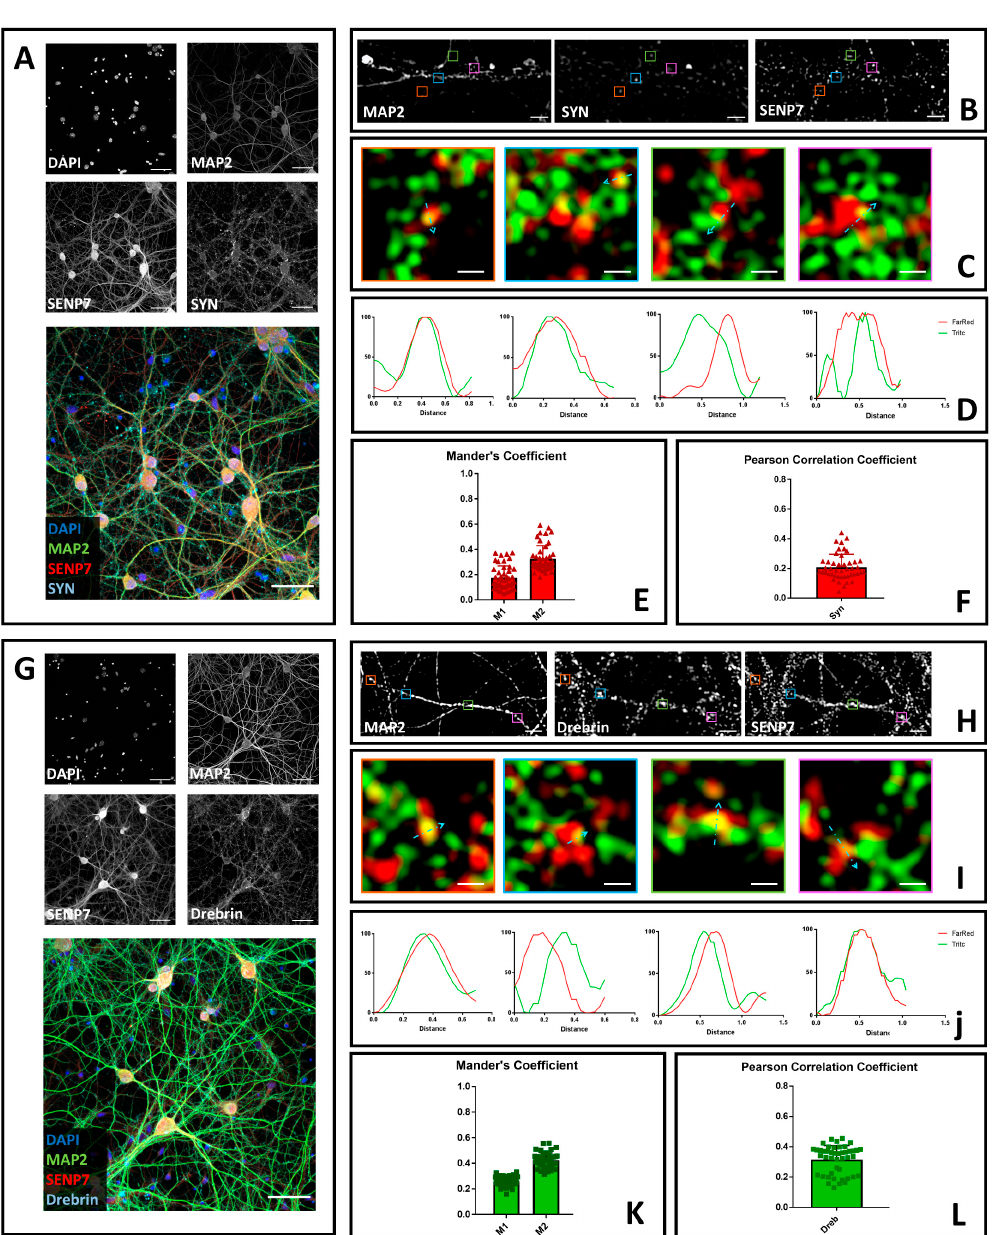
Figure 3. Confocal and SIM microscopy to determine the neuronal localization of SENP7. ( A ) Neurons were fixed and stained with anti-SENP7 (red), anti-synaptophysin (light blue) and anti-Map2 (green). Images were obtained using a Nikon N-SIM confocal microscope and overlaid to assess protein localization. Nuclei were stained with Hoechst. Scale bar of 50 μ m. ( B ) 3D-SIM images acquired with a 100× objective. Scale bar of 2 μ m. Squares represent the location of the inset present in panel C. ( C ) Merge images of reconstructed 3D-SIM images of SENP7 (green) and synaptophysin (red). Scale bar of 0.5 μ m. ( D ) Intensity profile (green for SENP7 and red for synaptophysin) representing the values indicated by the light blue arrow in panel C. The values were normalized to 100 (arbitrary unit). ( E ) Mander’s coefficients of SENP7 co-localization with synaptophysin (M1) and synaptophysin co- localization with SENP7 (M2). ( F ) Pearson’s Correlation Coefficient of SENP7 and synaptophysin (SYN). Data are the mean ± SD of 45 fields from three independent experiments. ( G ) Neurons were fixed and stained with anti-SENP7 (red), anti-drebrin (light blue), and anti-Map2 (green). Images were obtained using a Nikon N-SIM confocal microscope and overlaid to assess protein localization. Nuclei were stained with Hoechst. Scale bar of 50 μ m. ( H ) 3D-SIM images acquired with a 100× objective. Scale bar of 2 μ m. Squares represent the location of the inset present in panel C. ( I ) Merge images of reconstructed 3D-SIM images of SENP7 (green) and drebrin (red). Scale bar of 0.5 μ m. ( J ) Intensity